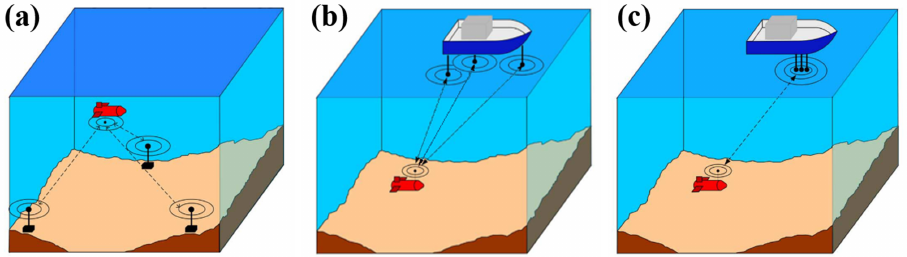
Figure 6. Acoustic Navigation: ( a ) LBL: long baseline system. ( b ) SBL: short baseline system. ( c ) USBL: ultra-short baseline system